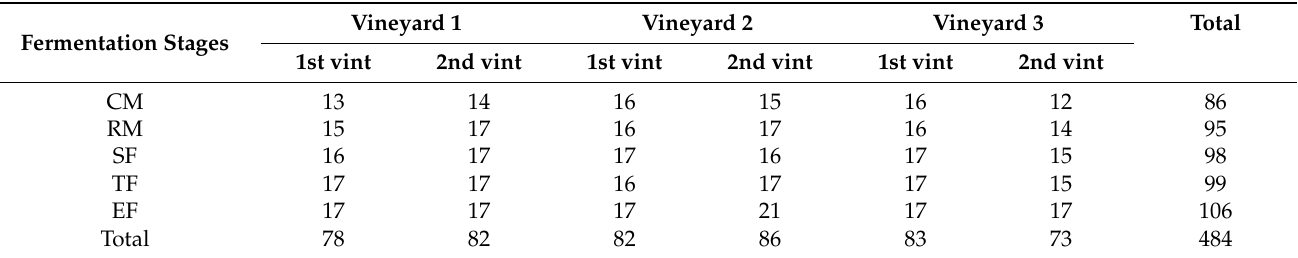
Table 1. Number of yeasts isolates analysed in this work, depending on the vineyard, vintage and fermentation stage.